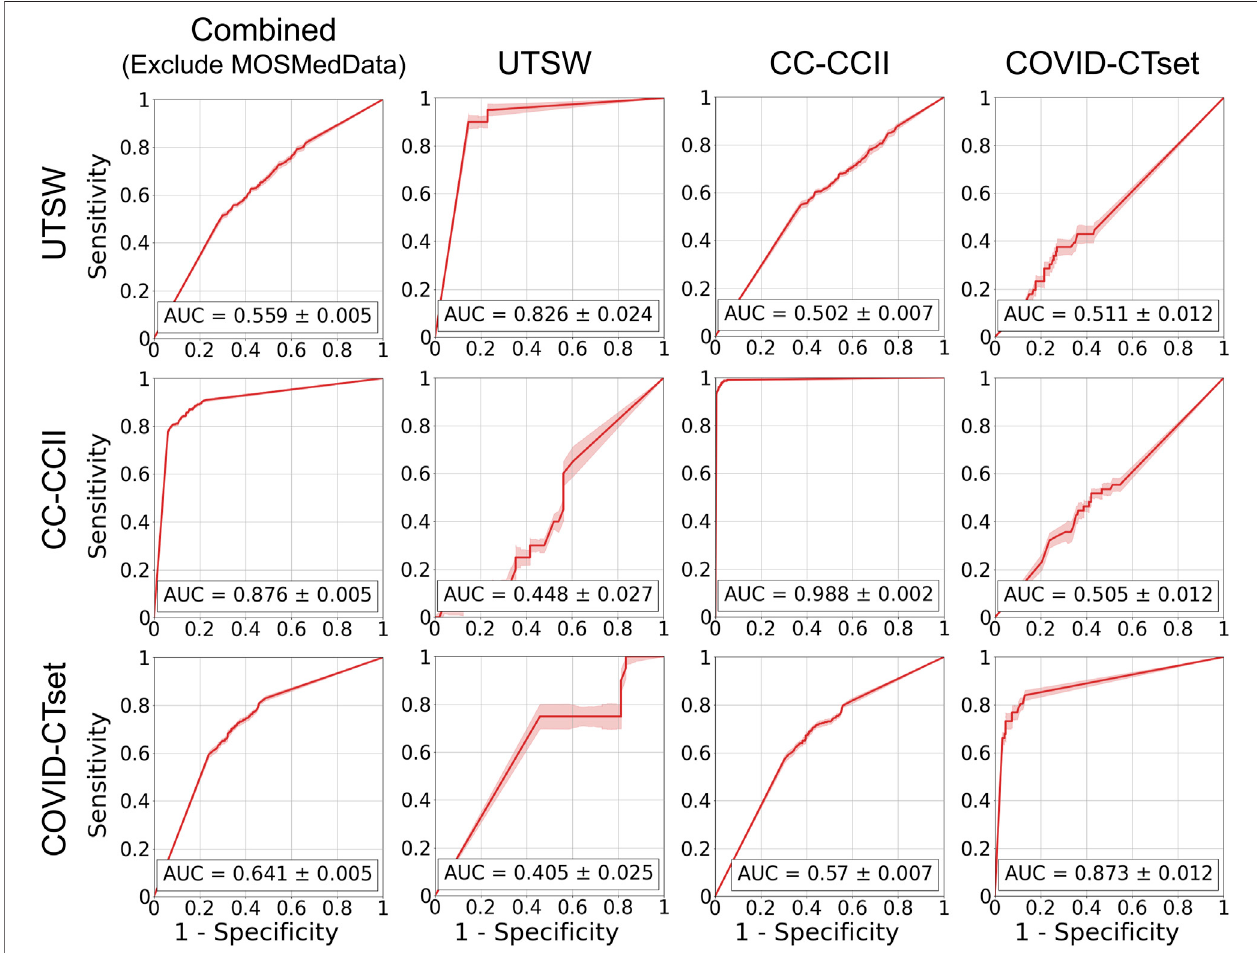
FIGURE 5 | ROC curves on the test data for the models trained on single datasets. Each row represents the datasets that the model was trained on, and each column represents the datasets that the model was evaluated on. The error band and the error value in the reported AUC represent 1 standard deviation.